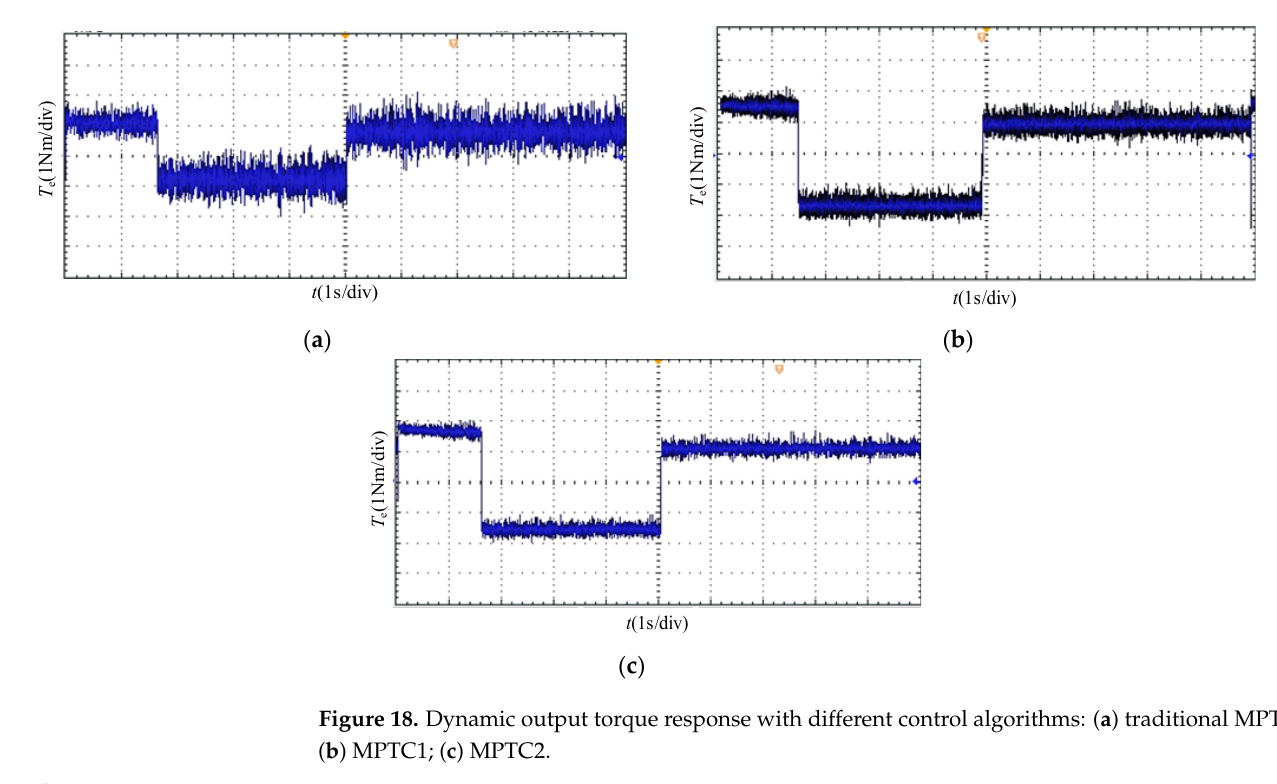
Figure 18. Dynamic output torque response with different control algorithms: ( a ) traditional MPTC;